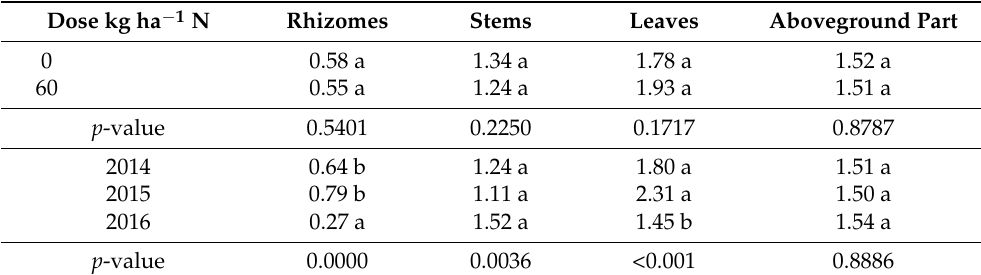
Table 5. Calcium content in dry matter of the giant miscanthus in g · kg − 1 (average for the years 2014–2016).